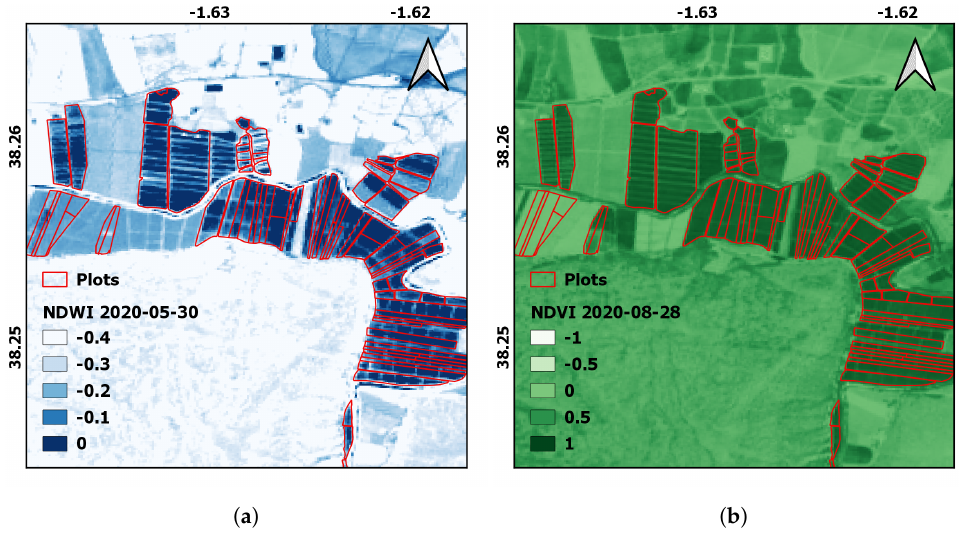
Figure 4. NDVI and NDWI indices of S2 for the study area. ( a ) NDWI index dated 30 May 2020 in the study area. ( b ) NDVI index dated 28 August 2020 in the study